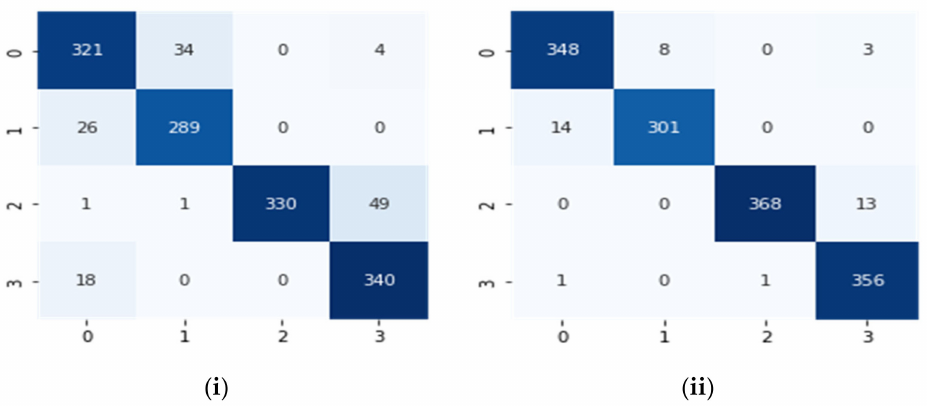
Figure 10. Confusion matrixes for ( i ) the compressed database and ( ii ) the decompressed